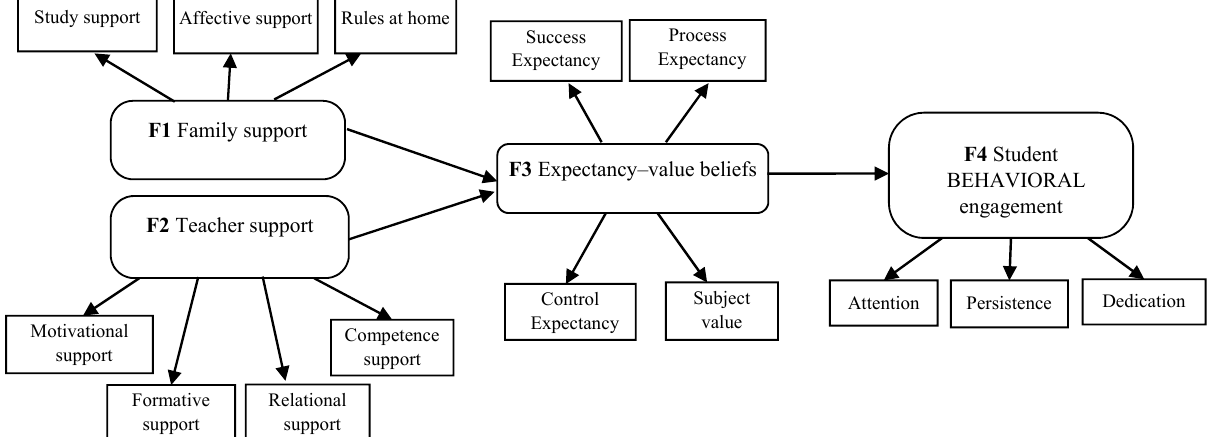
Figure 3. Hypothesized model (M1). Relations among family (Factor 1) and teacher (Factor 2) support, expectancy–value beliefs (Factor 3), and student behavioral engagement (Factor 4).